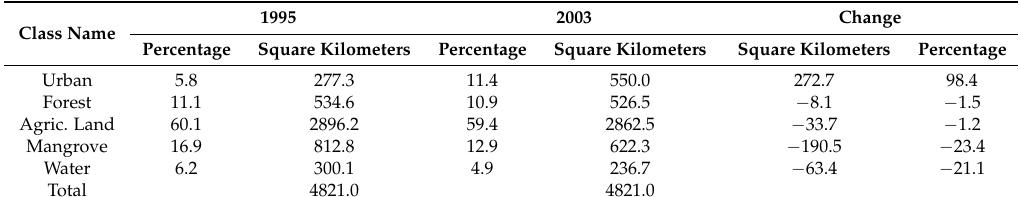
Table 4. Changes in urban area and other LULC categories between 1995–2003. Changes in this table indicate that urban area experienced a significant increase.